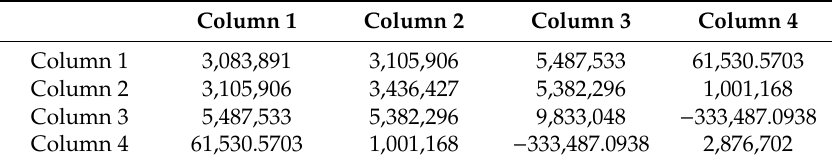
Table A4. Covariance matrix (see Table 1).